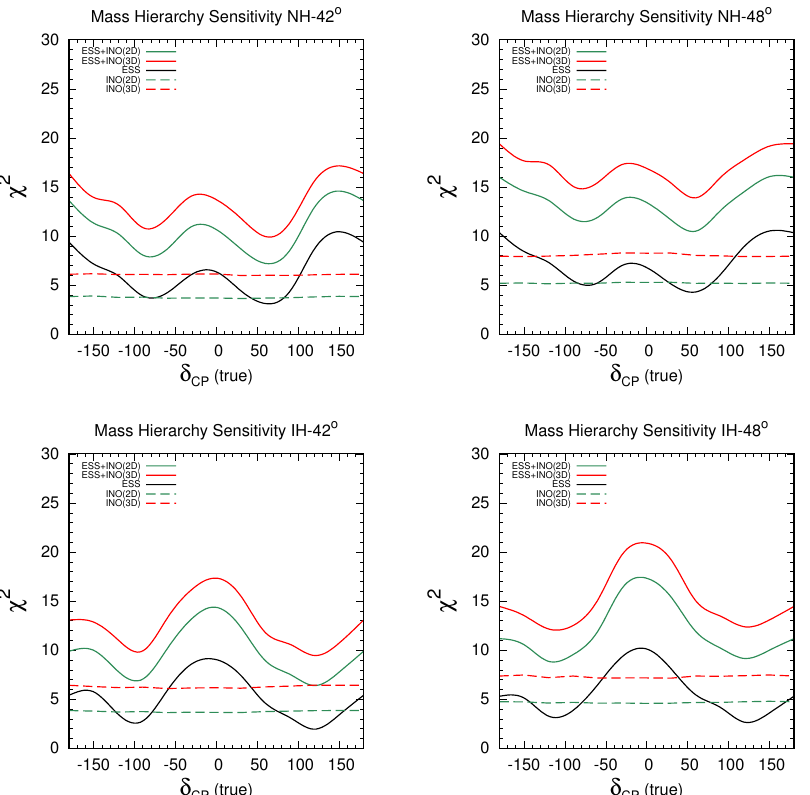
Figure 5 . Mass hierarchy sensitivity vs. (cid:14) CP (true) for ICAL@INO-3D, ICAL@INO-2D and ESS (cid:23) SB for four hierarchy-octant combinations starting from top right, clockwise in the order NH-LO, NH-HO, IH-HO and IH-LO. Each (cid:12)gure consists of (cid:12)ve di(cid:11)erent experimental combina- tions which are represented as ICAL@INO-2D (green dashed curve), ICAL@INO-3D (red dashed curve), ESS (cid:23) SB (black solid curve), ESS (cid:23) SB + ICAL@INO-2D (green solid curve) and ESS (cid:23) SB + ICAL@INO-3D (red solid